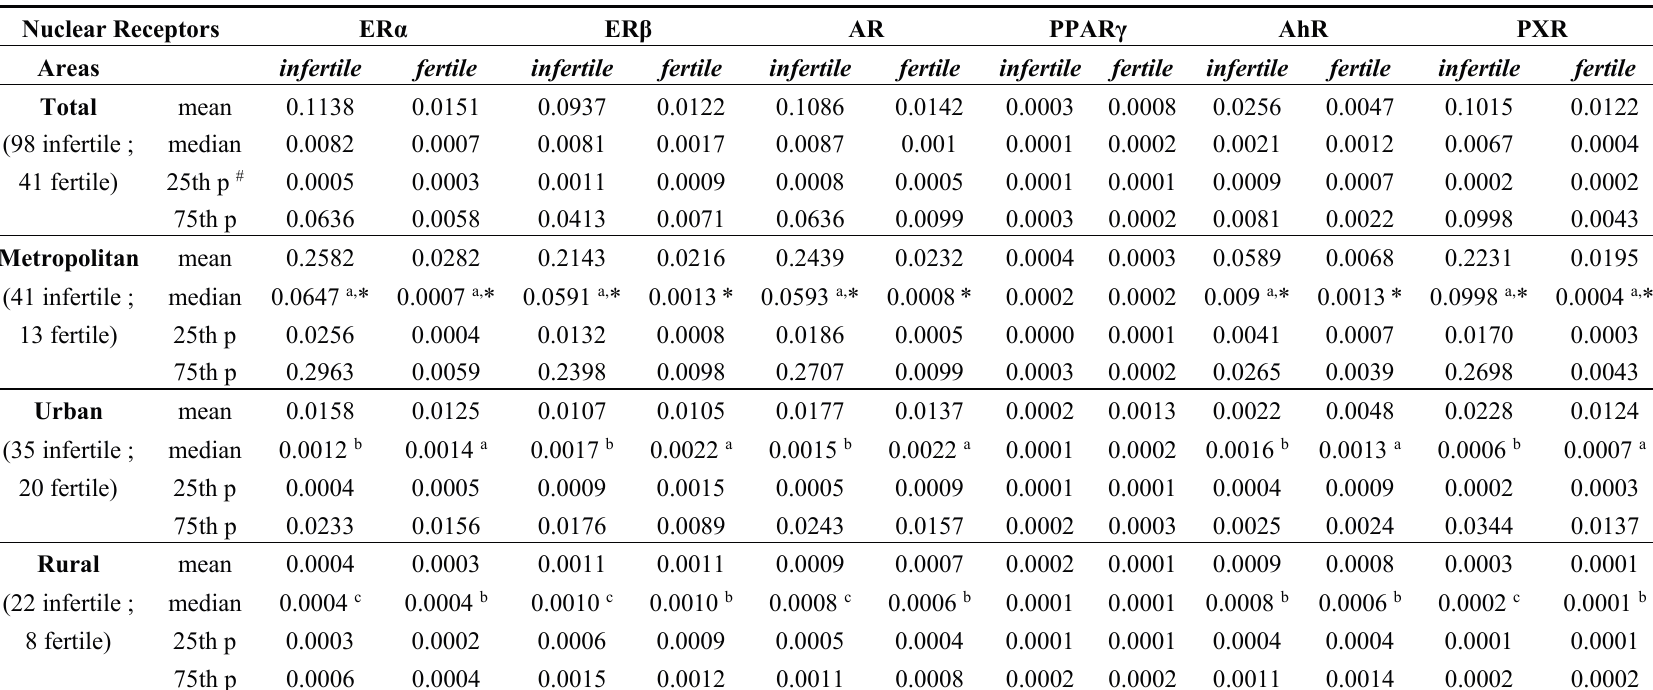
Table 5. Gene expression values of NRs in enrolled women grouped by area of residence and subject group. Data are expressed as 2 Δ Ct values with GAPDH as the reference